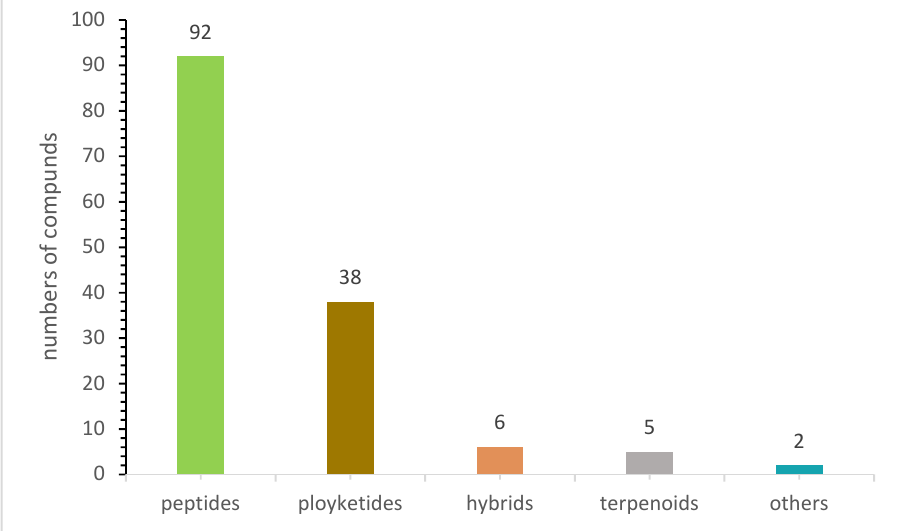
Figure 9. The structural classes of sulfur-containing compounds isolated from endophytic fungi.